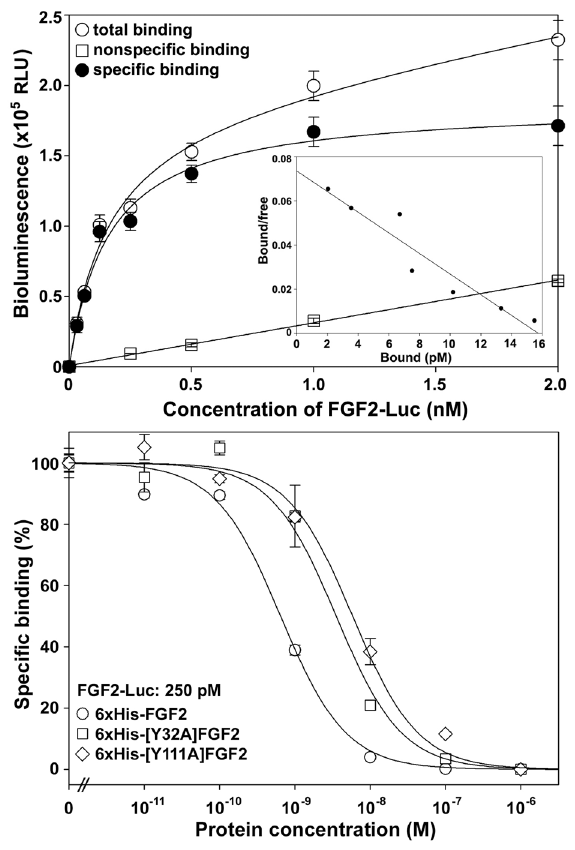
Fig 3. Binding of FGF2-Luc with the overexpressed FGFR1. Living HEK293T cells transiently overexpressing human FGFR1 (transcript variant 2) were used as the receptor source. (A) Saturation binding of FGF2-Luc with the overexpressed FGFR1. Nonspecific binding data were obtained by competition with 250 nM of 6×His-FGF2. The measured bioluminescence data were expressed as mean ± SE ( n = 3). The total binding data were fitted to Y = B max X/(K d + X) + N s X, specific binding data to Y = B max X/(K d + X), and nonspecific binding data to a linear curve. Inner panel, Scatchard plot of the specific binding data. (B) Competition binding of wild-type or mutant FGF2s with the overexpressed FGFR1 using FGF2-Luc as a tracer. The measured bioluminescence data were expressed as mean ± SE ( n = 3) and fitted with sigmoidal curves using the SigmaPlot10.0